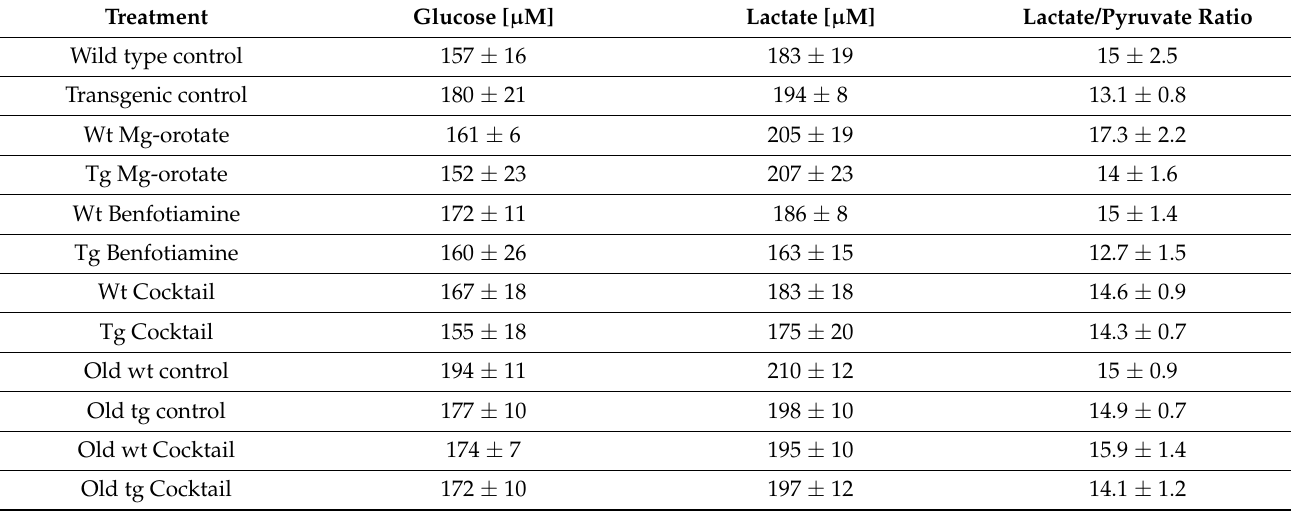
Table 1. Extracellular concentrations of metabolites as determined by microdialysis under basal conditions (not corrected for recovery) in rat hippocampus. Data are means ± SEM ( n = 8–10) and were analysed by one-way ANOVA. Glucose: F11,109 = 0.57, p = 0.85; Lactate: F11,109 = 0.86, p = 0.58; Lactate/Pyruvate ratio: F11,109 = 0.70, p =